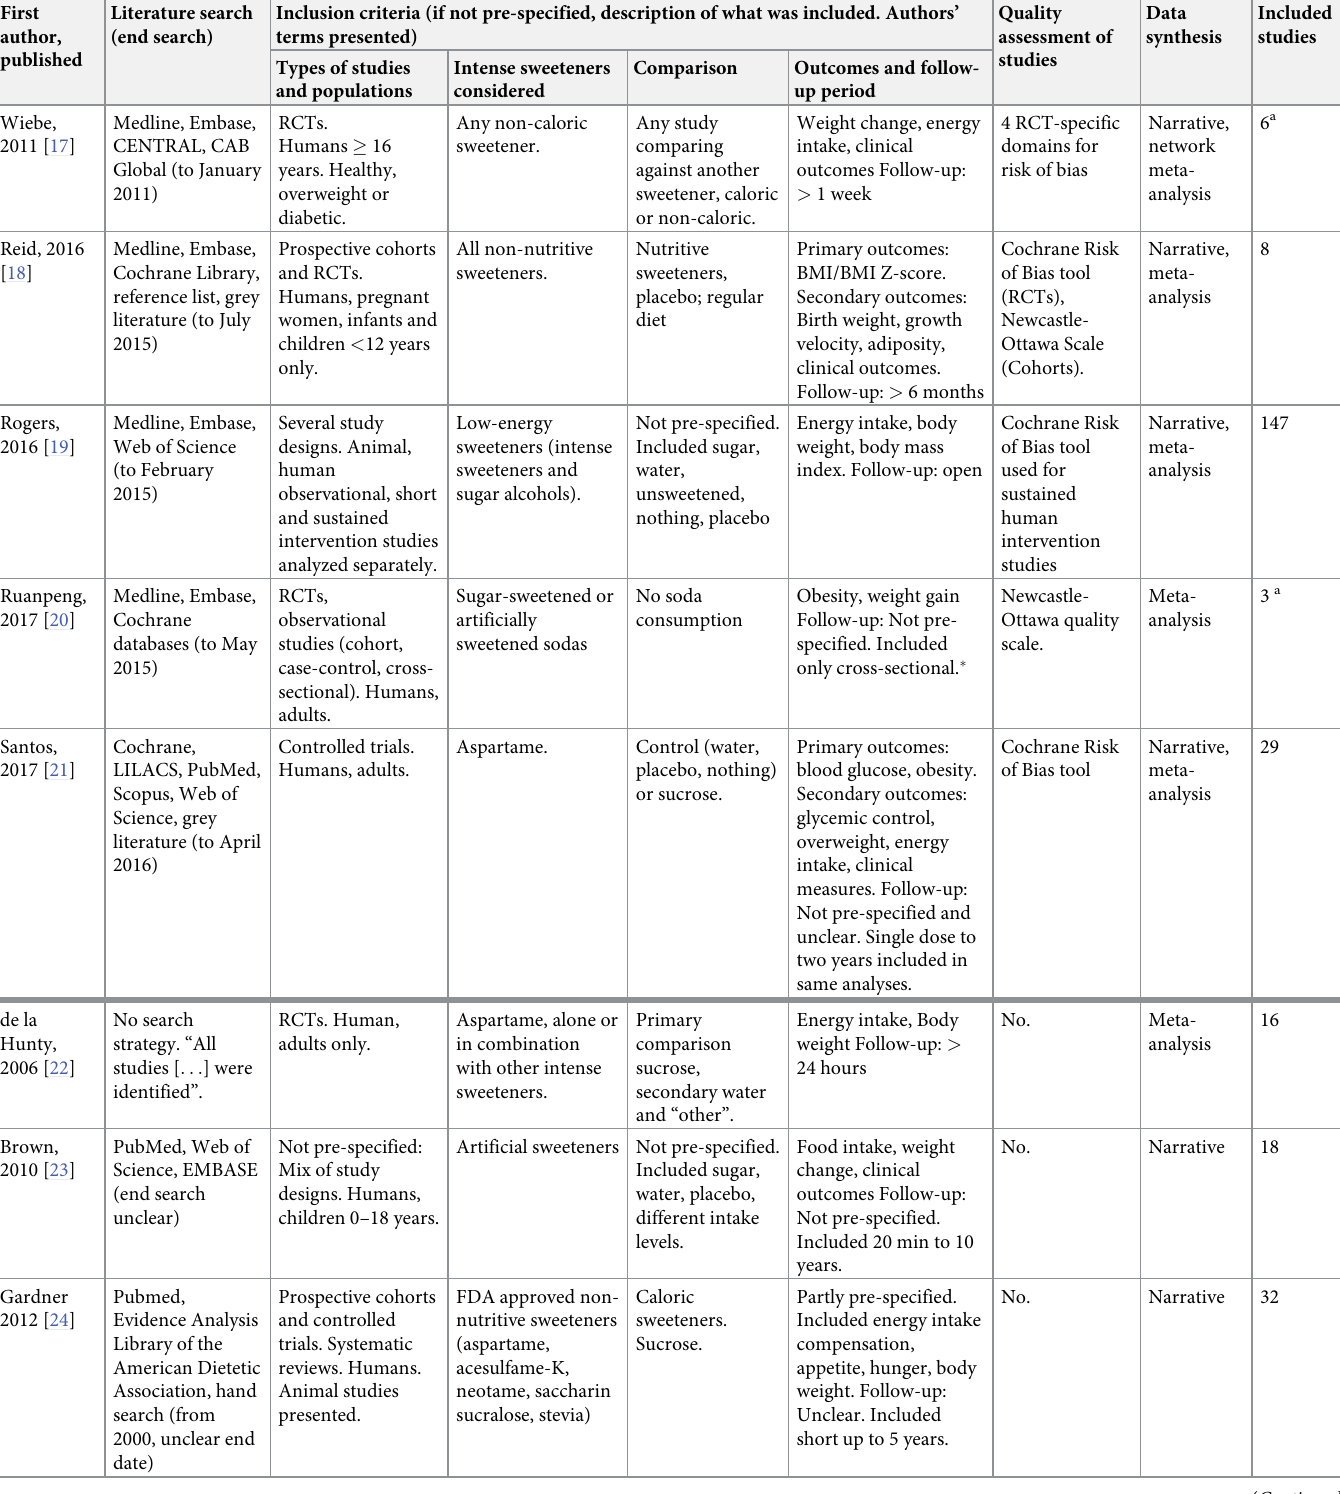
Table 1. Characteristics of included systematic reviews and reviews with some description of systematic approach to study